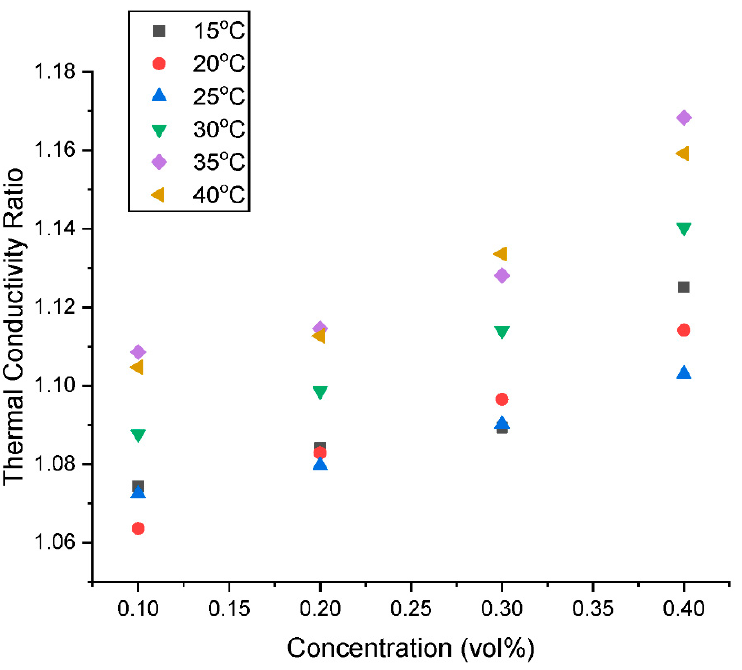
Figure 11. Influence of concentration on the thermal conductivity ratio of the hybrid nanofluids at various temperatures.